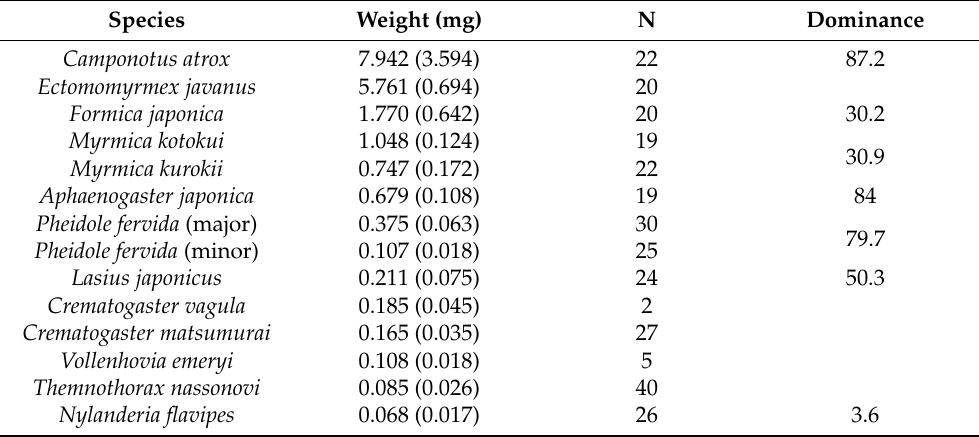
Table 3. Weight (mean ± standard deviation) and dominance of ants. Dominance is the percentage of dominant behavior during interspecific encounters, and therefore, dominant species have a high score [11].